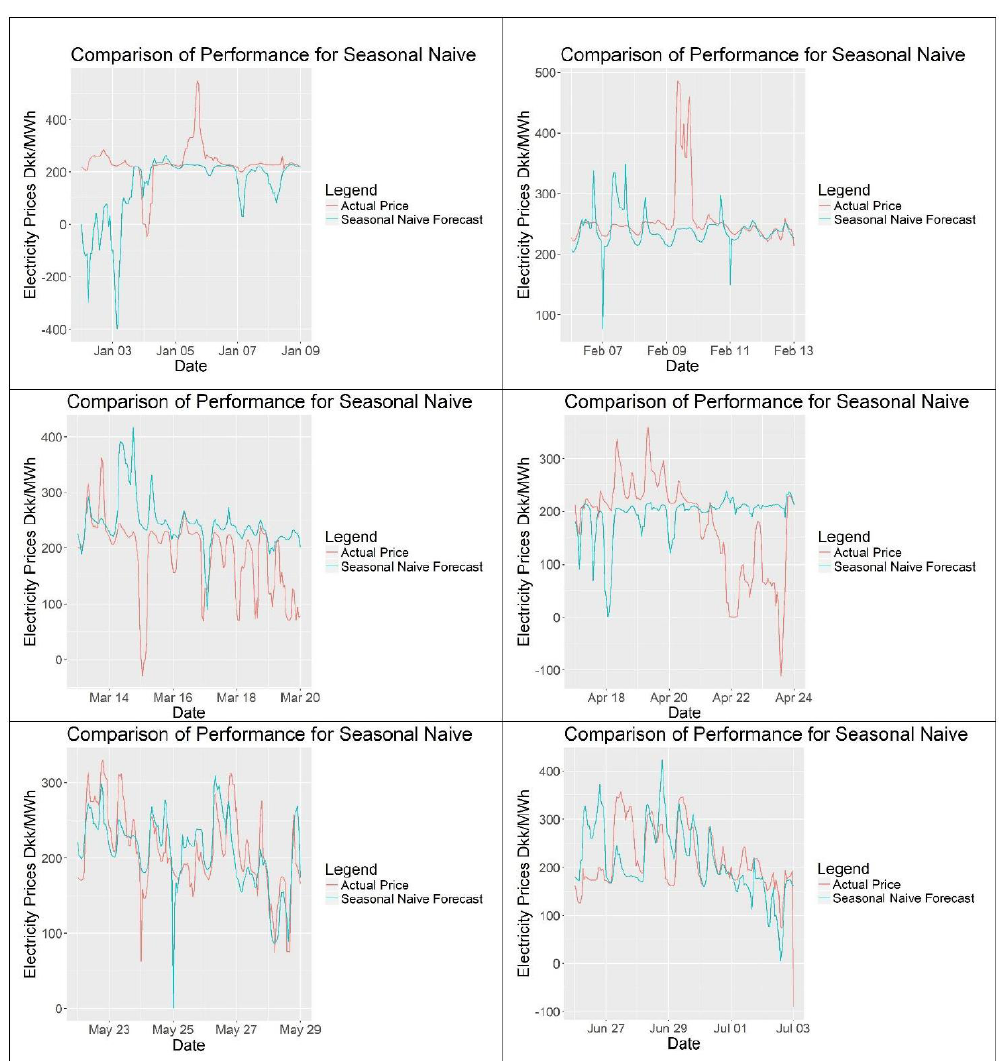
Figure 23. Six different weekly periods for Naïve.